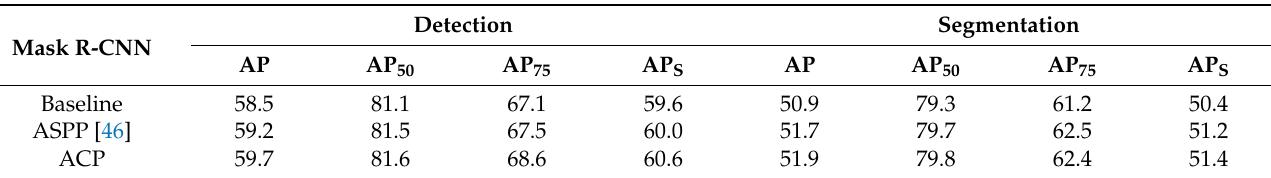
Figure 13. Visual results of models having only ACP or MSAM, and having both modules. ( a ) Ground truth. ( b ) The result of the model having only ACP. ( c ) The result of the model having only MSAM. ( d ) The result of the model having both modules. Red circles indicate false detections. Yellow circles indicate missed detections. Green circles indicate poor segmentation. Table 3. The comparison of ACP and ASPP